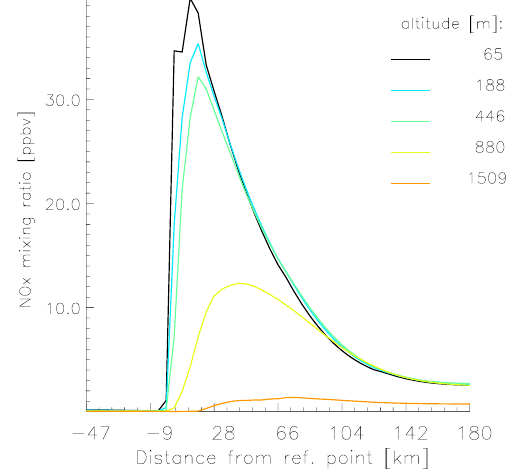
Fig. 16. Simulated NO x mixing ratio as in Fig. 14b, but for the simulations that consider the additional strong sources of NO x from the four power plants in